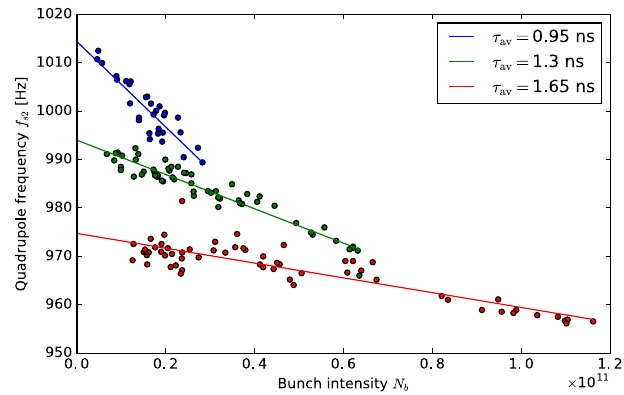
FIG. 13. Examples of measured quadrupole frequency f s 2 as a function of intensity for selected average bunch lengths τ (within (cid:3) 50 ps) in the Q20 optics. The lines correspond to a linear